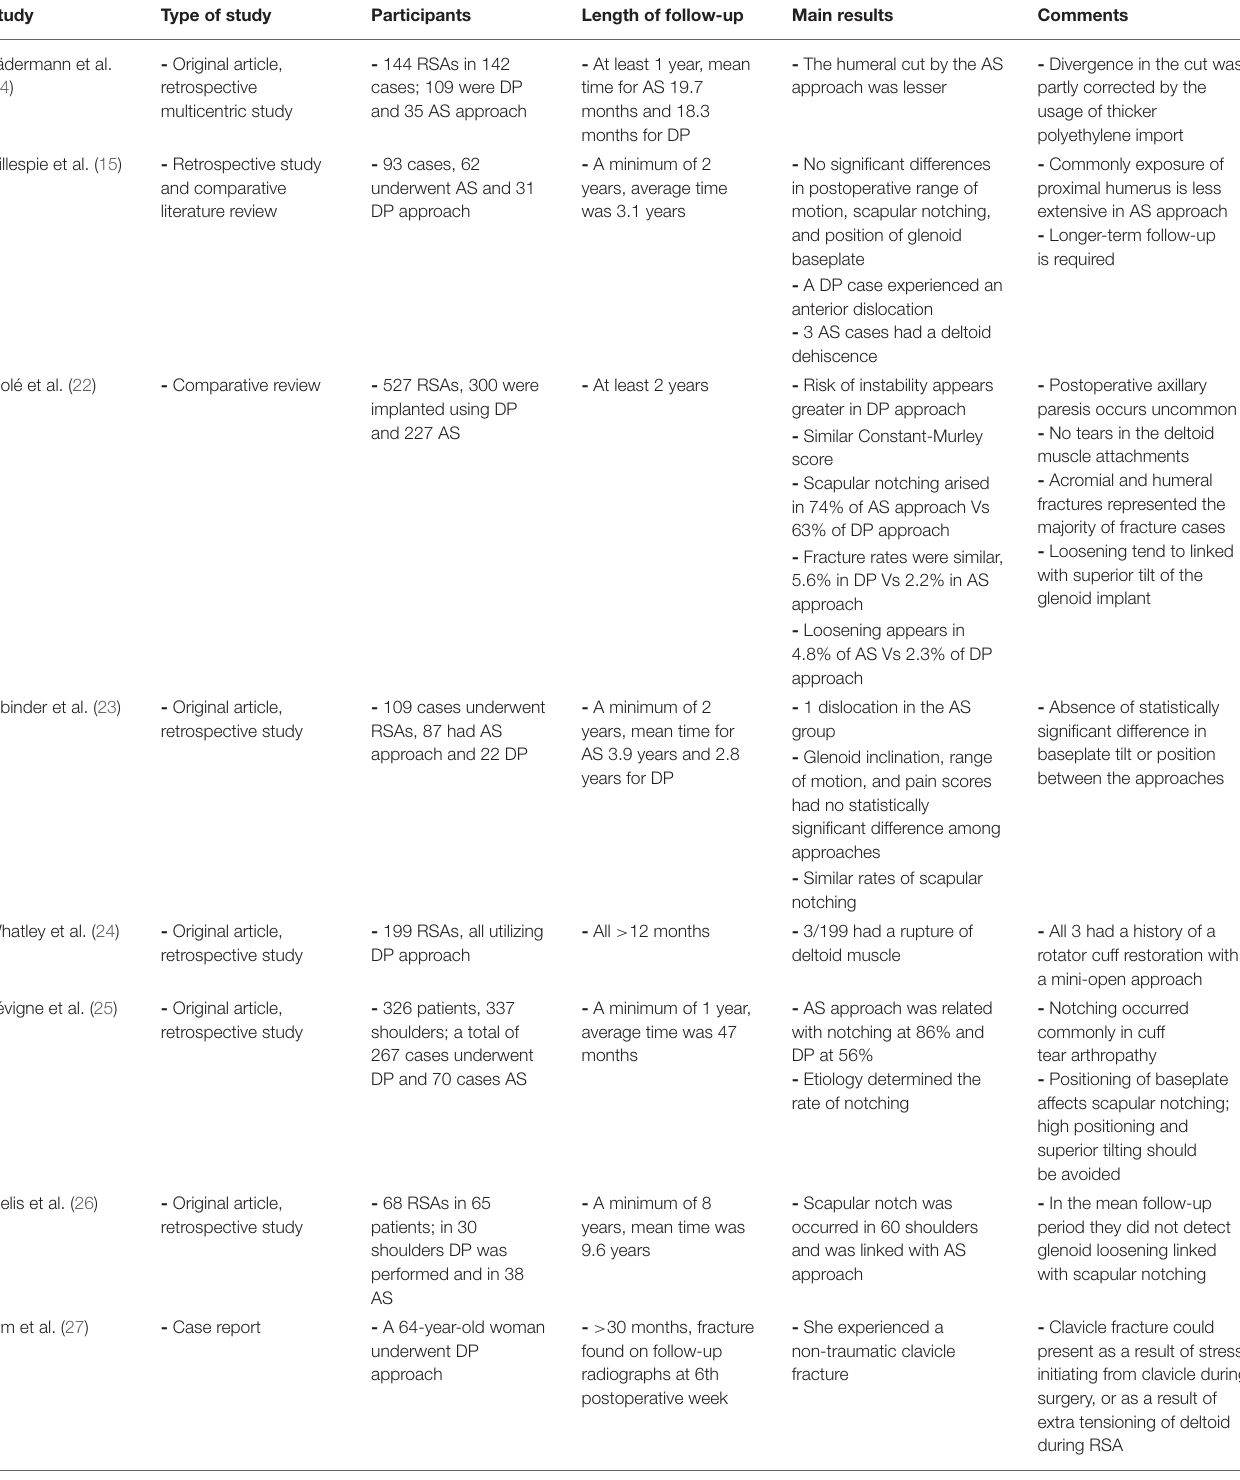
TABLE 2 | Summary of studies assessing deltopectoral and anterosuperior approaches in RSA.